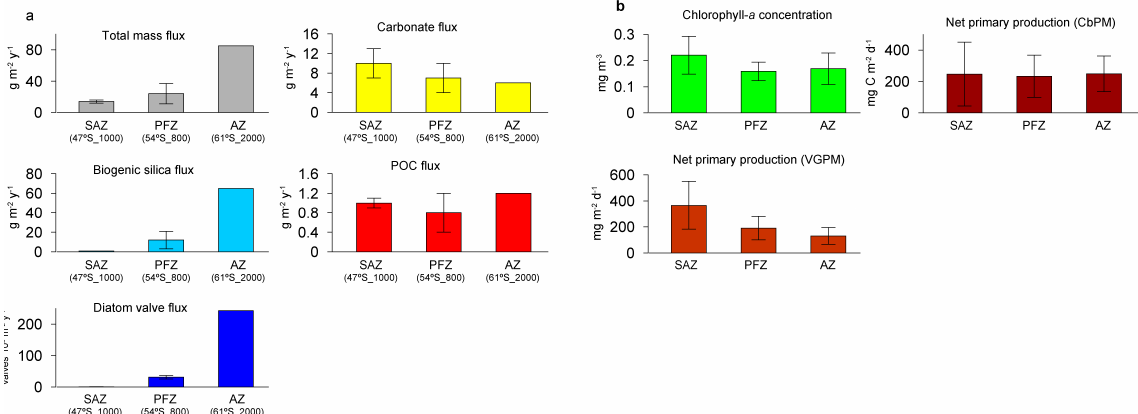
Figure 8. (a) Annual mean total mass, major component and diatom-valve fluxes for the <1mm particulate fraction for the 47, 54 and 61 ◦ S sites. (b) Annual average of chlorophyll a concentration and two different estimates of primary productivity (standard vertically generalized production model – VGPM; and carbon-based production model – CbPM) for the 47, 54 and 61 ◦ S sites from October 1997 to September